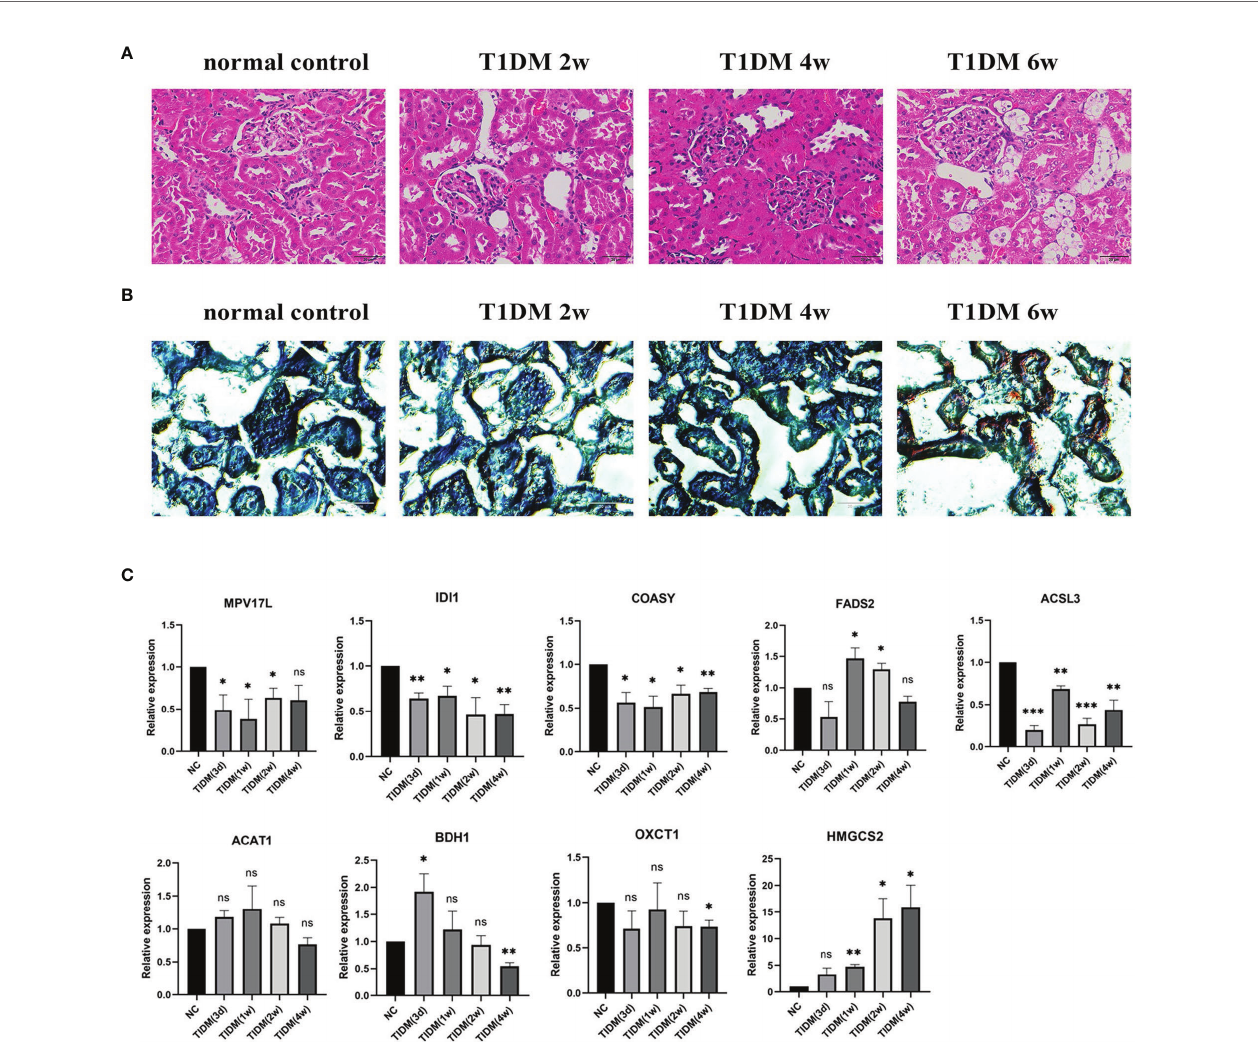
FIGURE 5 | Morphological changes of kidney and qPCR con fi rmation in T1DM rats: (A) Hematoxylin & eosin (HE) staining of renal tissue. (B) Oil Red O staining of renal tissue. (C) The mRNA expression level of some genes of interest in T1DKD rats. Data are presented as means ± SEM of at least three independent experiments.